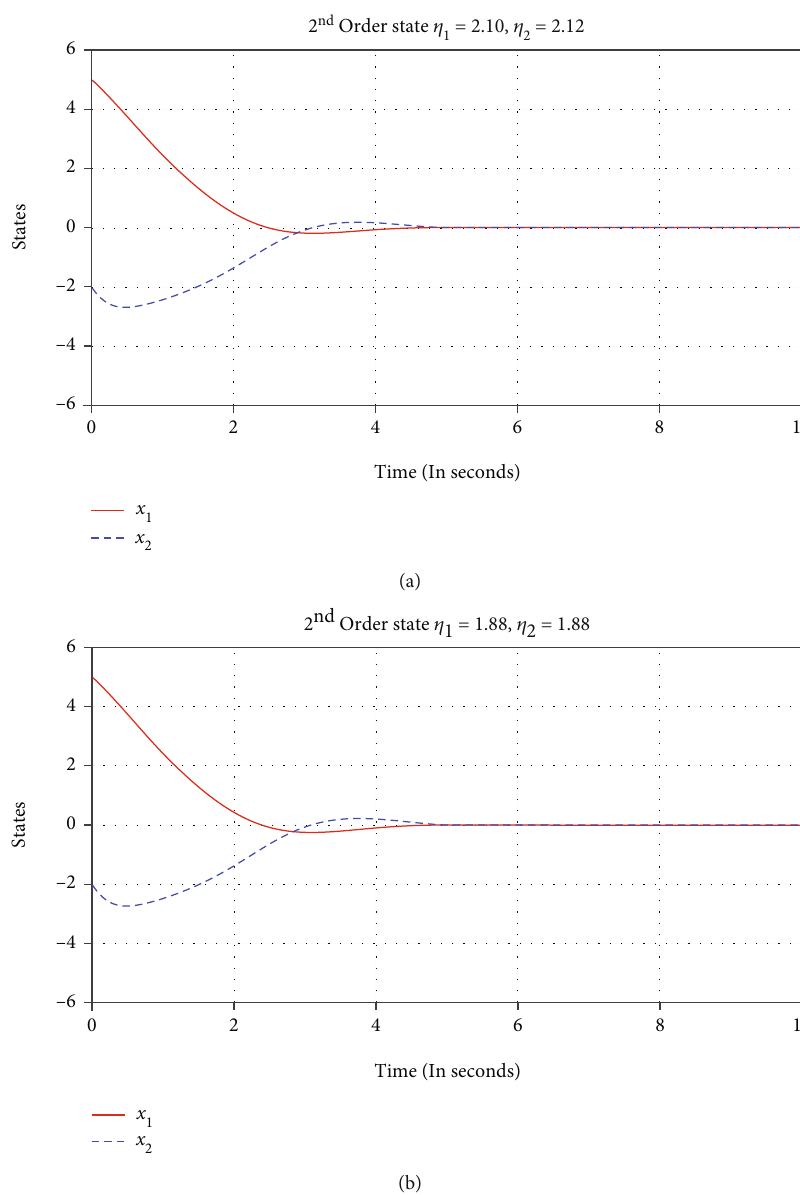
Figure 2: The states curve of the second-order system with parameters (a) η